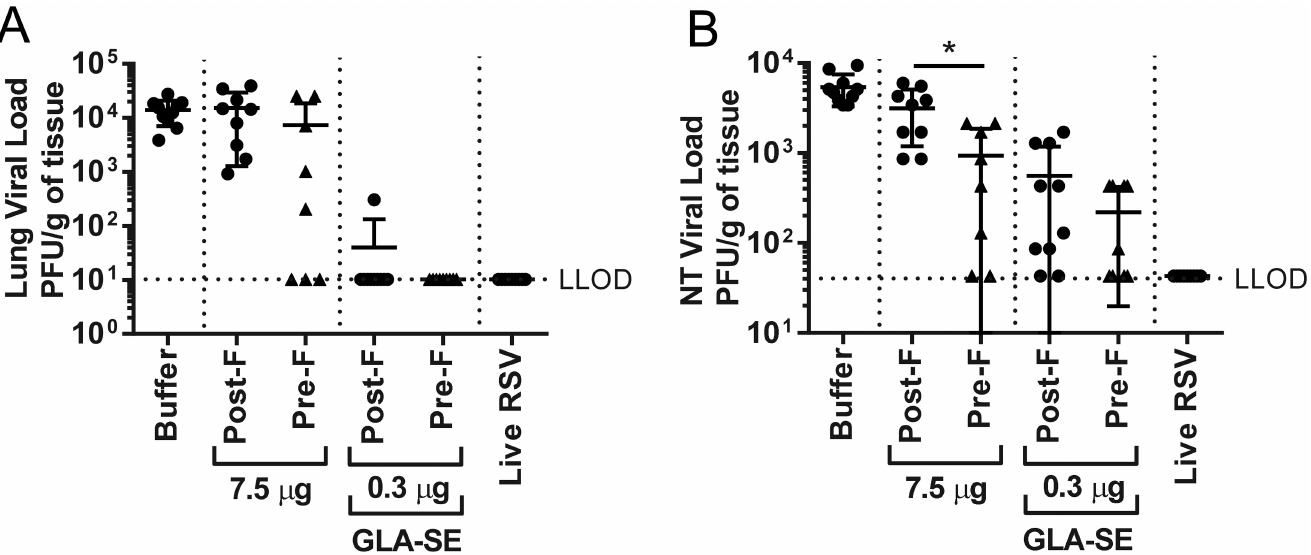
Fig 6. Protection from RSV A2 challenge in aged seronegative mice, immunized with pre- and post-RSV F. Aged (18 months old) BALB/c mice (n = 6 to 10 per group) were immunizedi.m. at day 0 and day 21 with buffer alone, RSV F (pre- or post- conformation) at the indicateddoses +/- GLA-SE (2.5 μ g/2%) adjuvant. A control group for natural infectionwas immunizedi.n. with live RSV (10 6 PFU) at day 0. At day 35, animalswere challenged i.n. with 10 6 PFU of wt RSV A2. 4 days post-RSV A2 challenge, (A) lung and (B) nasal turbinatesviral loads were measuredby plaqueassay. For statistical analyses, aged and youngmice were compared. * , P < 0.05.